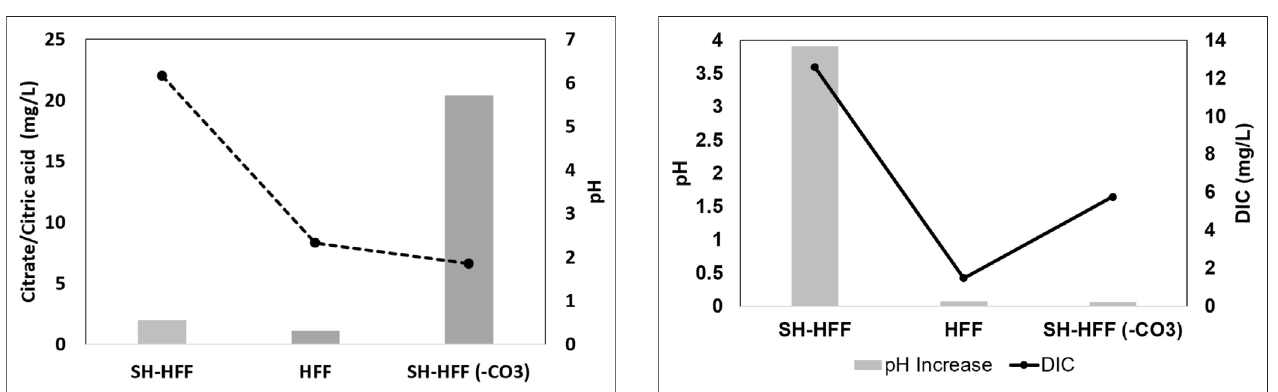
FIGURE 7 | Citrate plotted against pH demonstrating the pH dependency of calcium citrate.